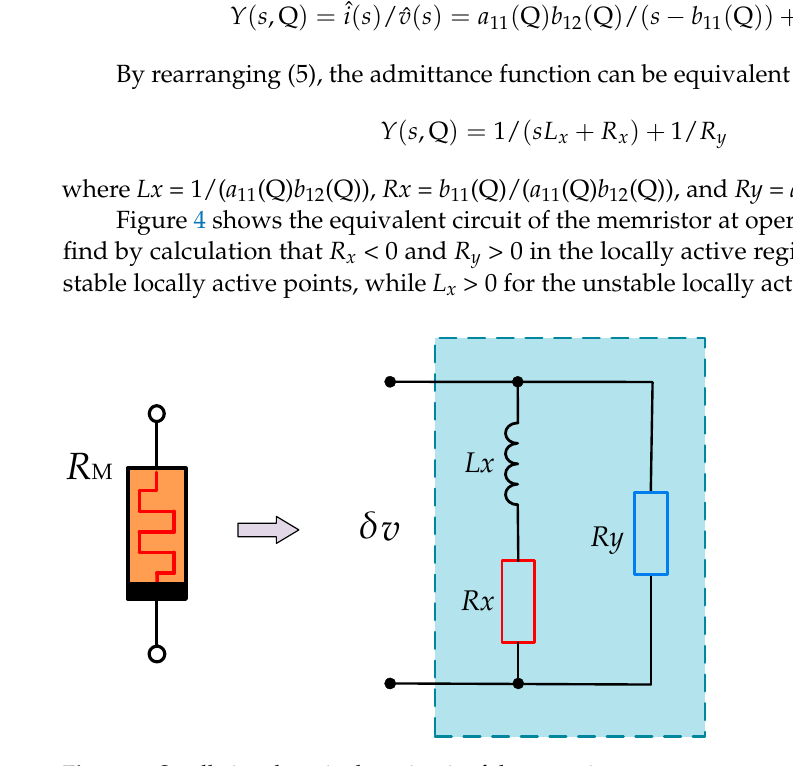
where K = a 12 (Q), Z = ( a 12 (Q) b 11 (Q) − a 11 (Q )b 12 (Q))/ a 12 (Q), and P = b 11 (Q). Figure 5 shows the pole and the zero trajectories of the admittance function Y ( s , Q) with respect to the voltage V , where the solid and the dotted lines represent the poles and zero, respectively. The purple dotted line segment on the pole curve and the blue dotted line segment on the zero curve represent the zero and pole values of the memristor in the locally active regions, respectively. Obviously, P > 0 and Z < 0 for the stable locally active regions, while P < 0 and Z > 0 for the unstable locally active